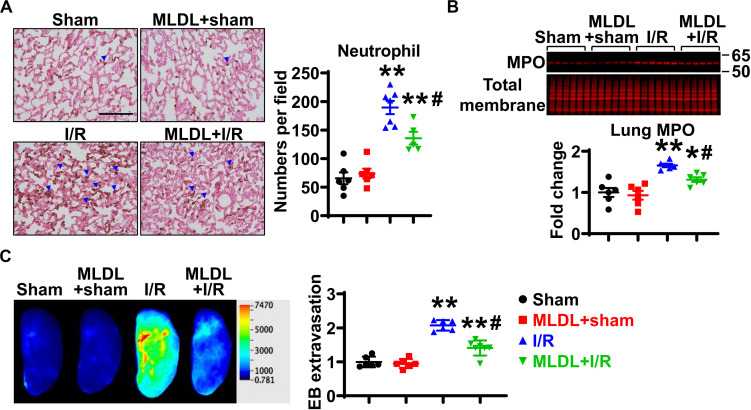
MLDL attenuates intestinal I/R-induced Lung neutrophil infiltration and microvascular permeability. (A) Intestinal I/R causes neutrophil recruitment into the lung, which is attenuated by MLDL. The blue arrowheads indicate neutrophils (brown dots). Scale bar, 100 μm. (B) Intestinal I/R elevates lung MPO expression, an effect ameliorated by MLDL. (C) Lung microvascular permeability (Evans blue extravasation) is increased after gut I/R, which is alleviated by MLDL. n = 6–7/group. *p < 0.05, **p < 0.01 vs. sham or MLDL + sham and #p < 0.05 vs. I/R. One-way ANOVA was used.